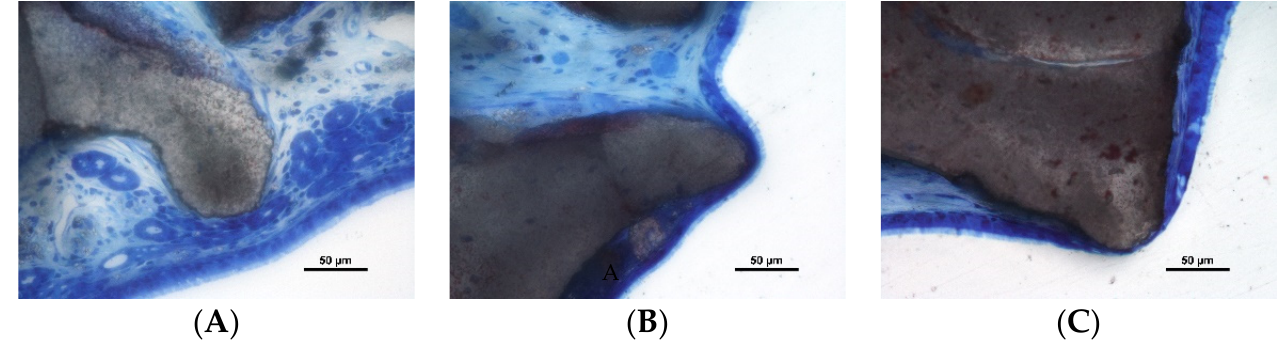
Figure 3. Photomicrographs of ground section of high-T sites: ( A ) vessels and mucous glands dislocated by the granules; ( B ) thinning of the epithelial cells still presenting cilia; ( C ) tapered epithelial cells adjacent a very thin remnant of sinus mucosa. Stevenel’s blue and alizarin red stain. Perforations of the sinus mucosa were observed in both periods and biomaterials (Figures 4A–C and 5A–C). Granules were found trespassing the sinus mucosa and the per- forations were bordered by a tapered epithelium. In some instances, the regions presented none or few inflammatory cells (Figure 4A,B). However, in other cases, an inflammatory infiltrate was encompassing the granules (Figure 4C).